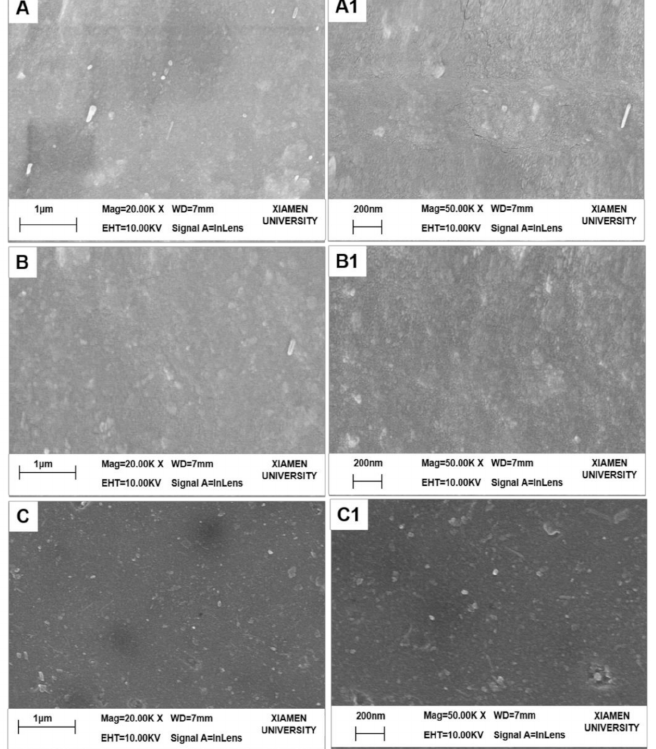
Figure 4. SEM images of UF and NF membranes ( A – C : 20.00 K × , A1 – C1 : 50.00 K × ): ( A ) PES substrate, ( B ) M3 membrane, ( C ) M3/AGQDs-0.2 NF membrane.